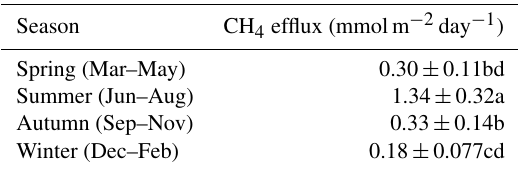
Figure 3. Seasonal variations of CH 4 effluxes and sediment temper- atures in Poyang Hu. White circles represent the variation of CH 4 effluxes, and black circles describe the variation of sediment tem- perature in the 4-year period. Table 1. Seasonal mean of CH 4 effluxes with the chamber measure- ments in Poyang